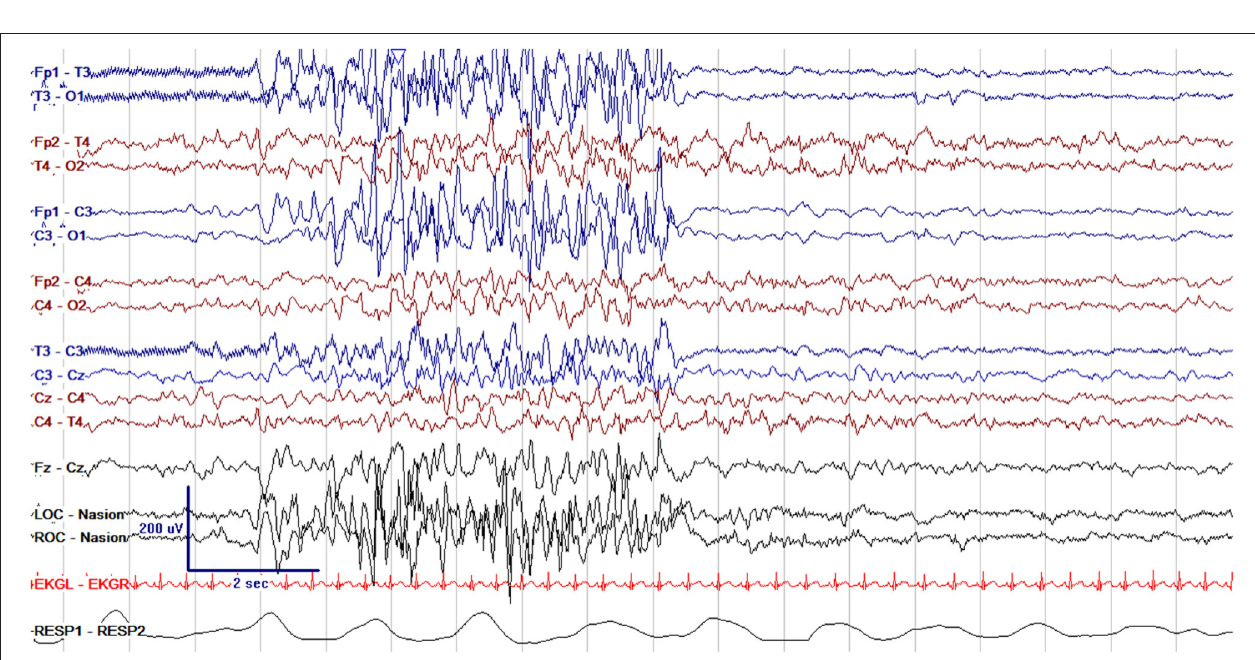
FIGURE 6 | Abnormal asymmetric cEEG with discontinuous high amplitude bursts of epileptiform activity in the left hemisphere and more normal continuity and voltage in the right hemisphere in a 10 day old former 39 + 1 week GA (40 + 4 week PMA) with left hemimegalencephaly.